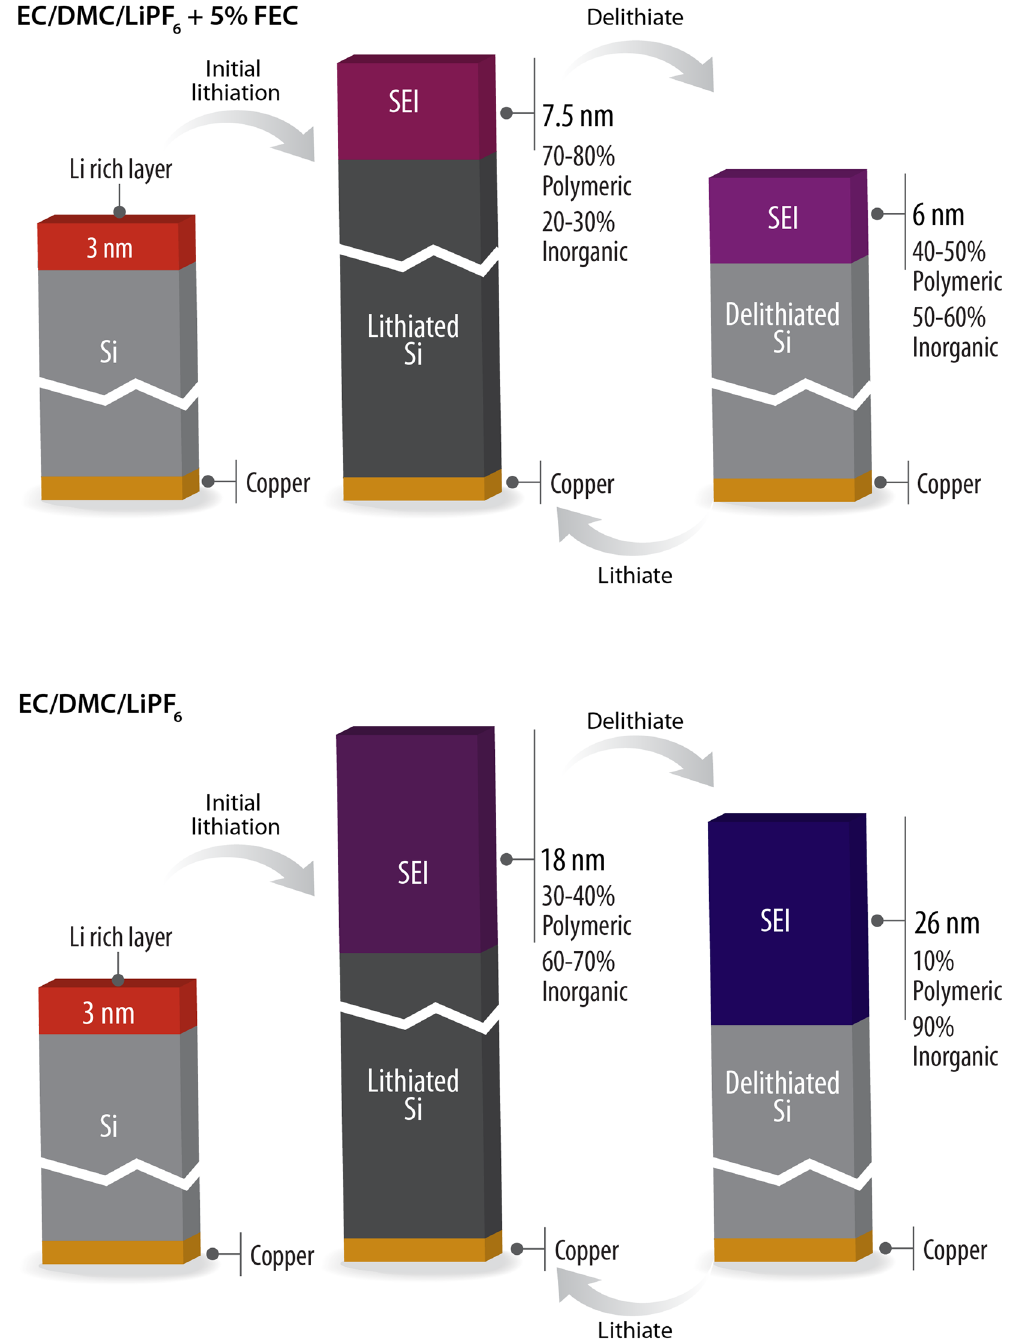
Figure 10. Graphical summary of SEI layer chemistry grown on silicon with and without